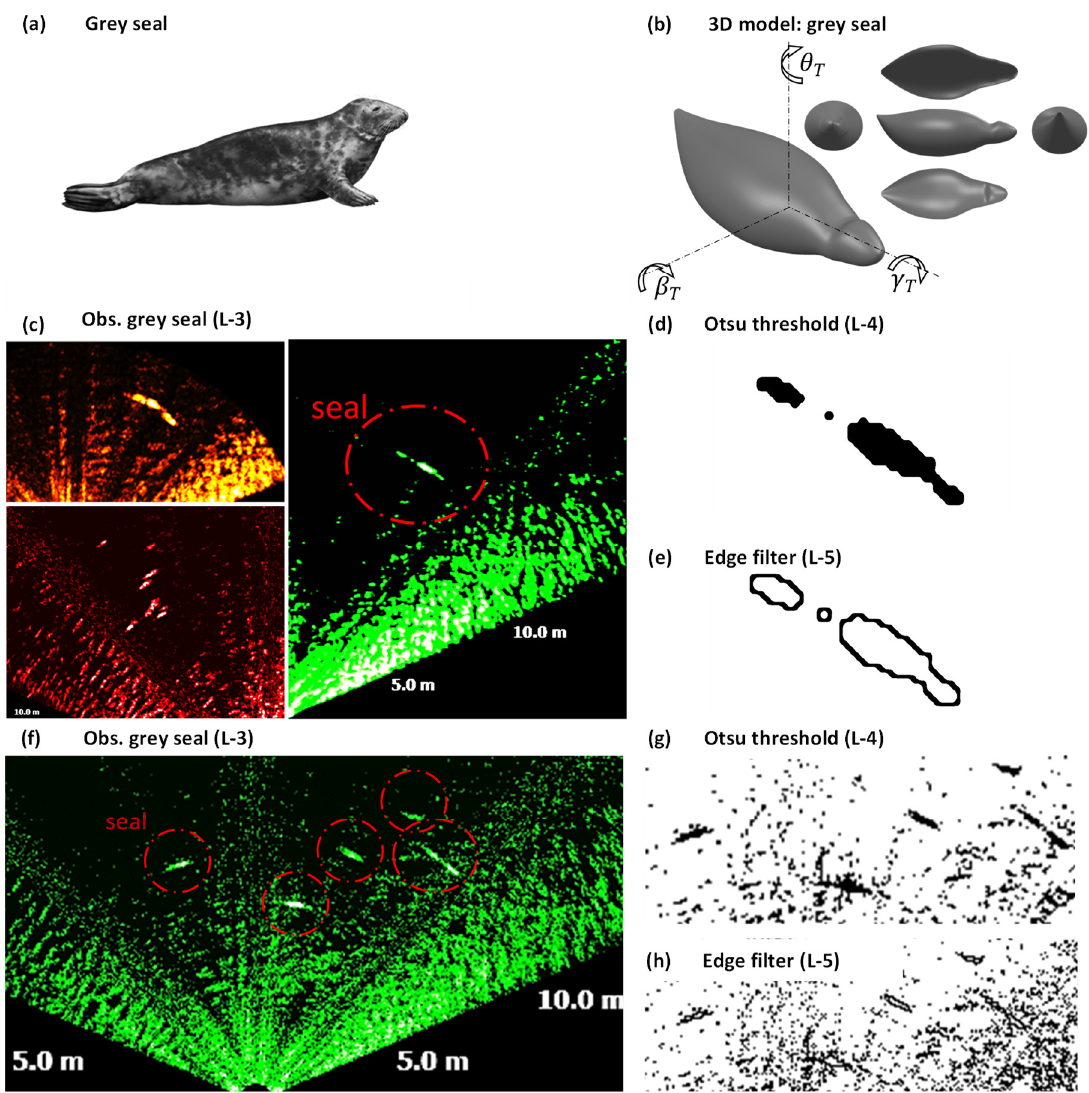
Figure 7. ( a ) Image of grey seals. ( b )Three dimensional model of a grey seal. ( c ) Acoustic images of grey seals at level 3, ( c ) measuring 3 m of length, located at 6 m of range; and ( f ) measuring 2.2 m, located at 6 m of range. The shape and silhouette of grey seals processed using ( d and g ) binary thresholds, ( e and h ) outline filters.